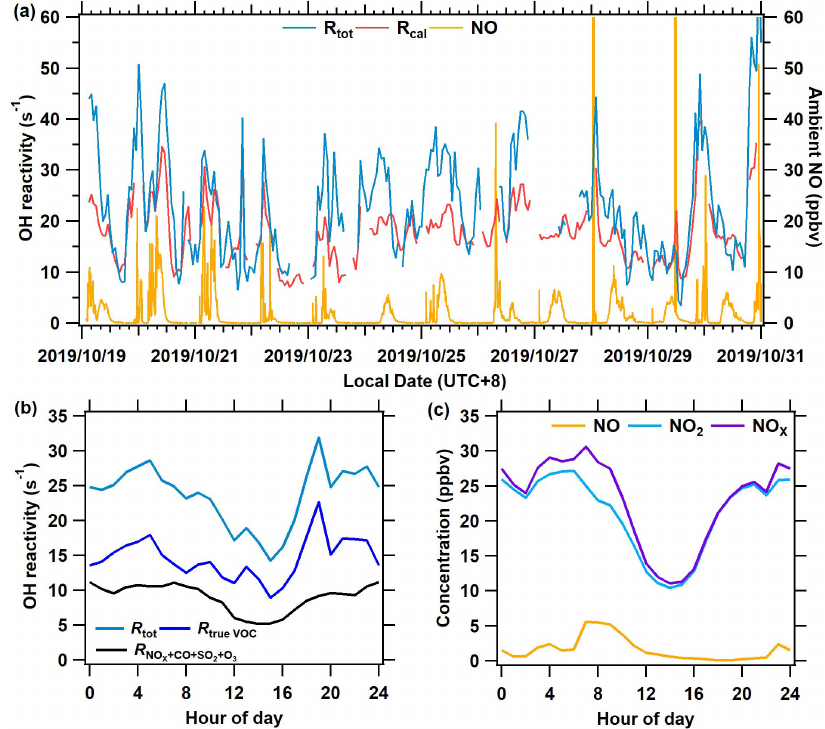
Figure 8. The measurement results of OH reactivity and ambient NO at the Heshan site from 19 to 31 October 2019. (a) The time series of total OH reactivity ( R tot ), calculated reactivity ( R cal ), and ambient NO concentration. (b) The mean diurnal profile of OH reactivity of R trueVOC , R NO , and R tot . (c) Mean diurnal profiles of measured NO, NO 2 , and NO x x + CO + SO 2 + O 3